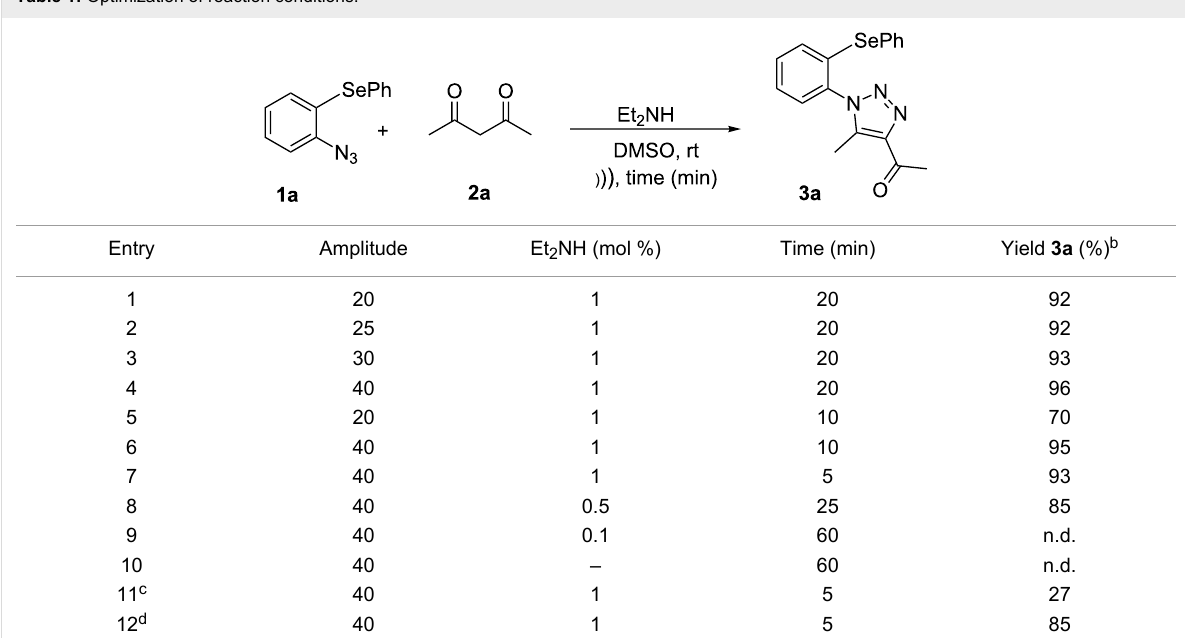
Table 1: Optimization of reaction conditions.